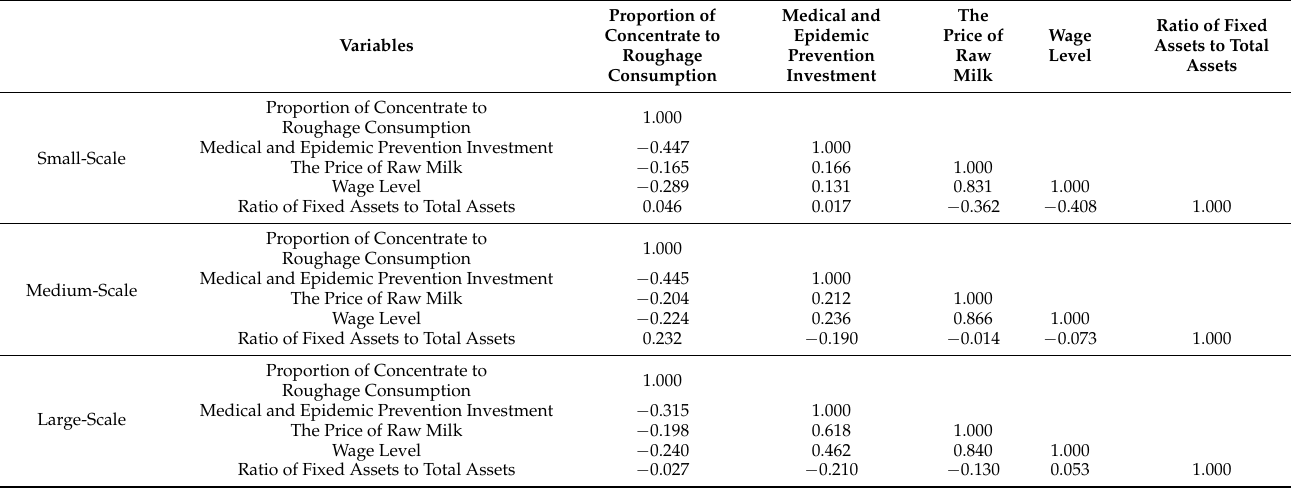
Table 13. Variable correlation coefficient matrix.